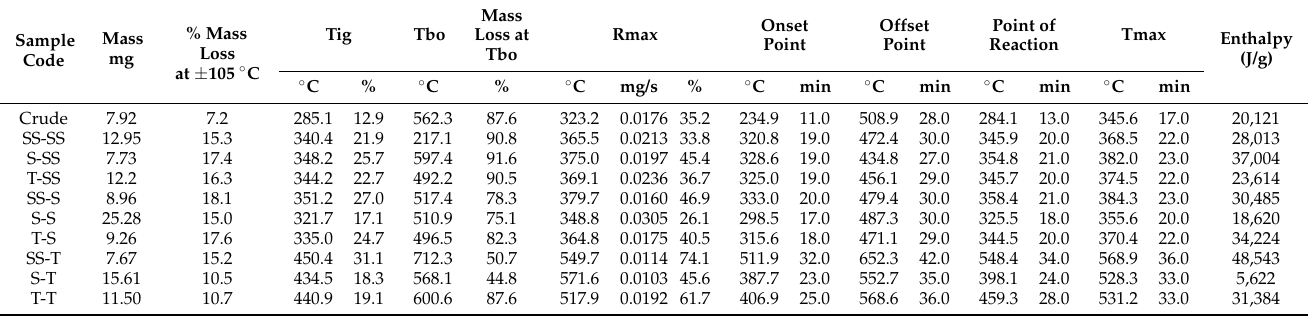
Table 3. Summary of DTG-DSC.